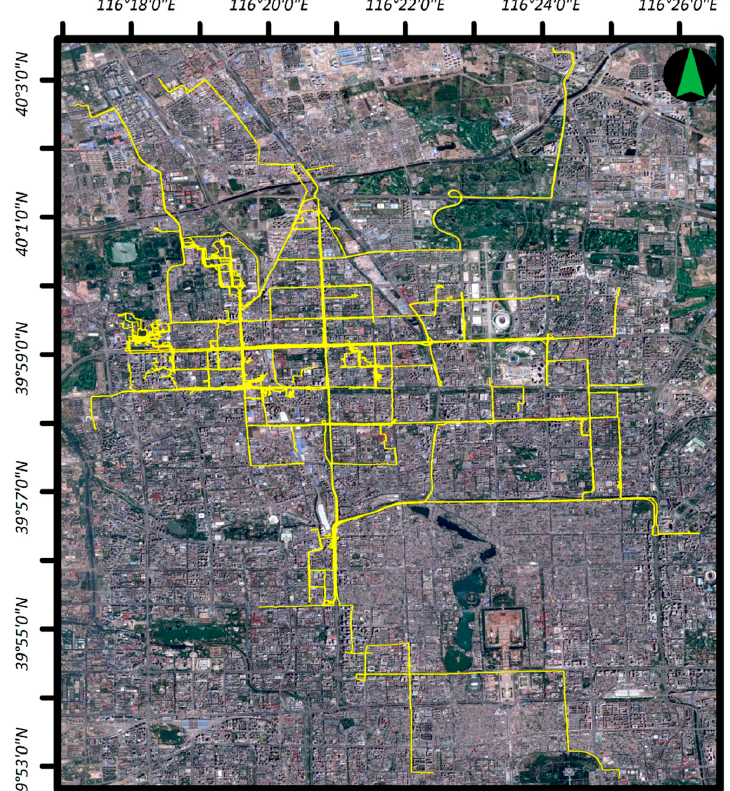
Figure 14. Geolife trajectories sample extract [14].